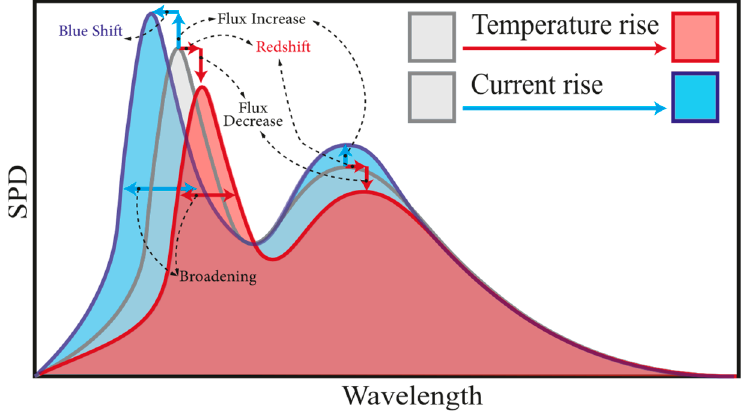
Figure 2. An illustration of temperature and input current induced changes in spectral power distribution (SPD) for an arbitrary WLED. At high temperatures, shown by the gray to red color transition in the figure, radiant flux reduction due to thermal droop, a red shift in dominant wavelengths of chip and phosphor, and full width at half maximum (FWHM) broadening are expected. At higher input current, shown in grey to blue color transition, an increase in power output, blue shift, and broadening at the chip’s FWHM can be seen.